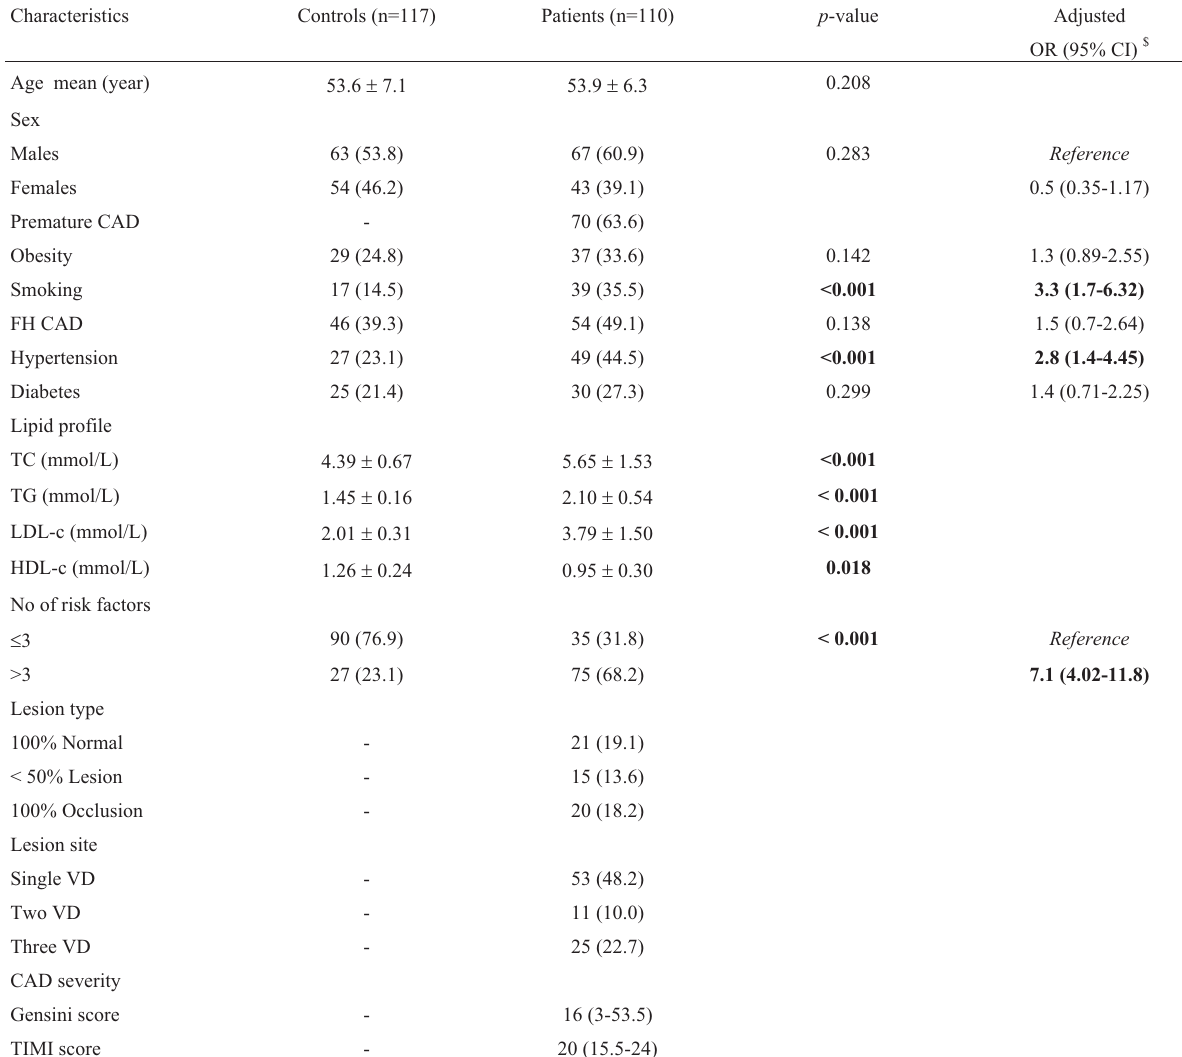
Table 1 - Baseline characteristics of CAD patients and controls.